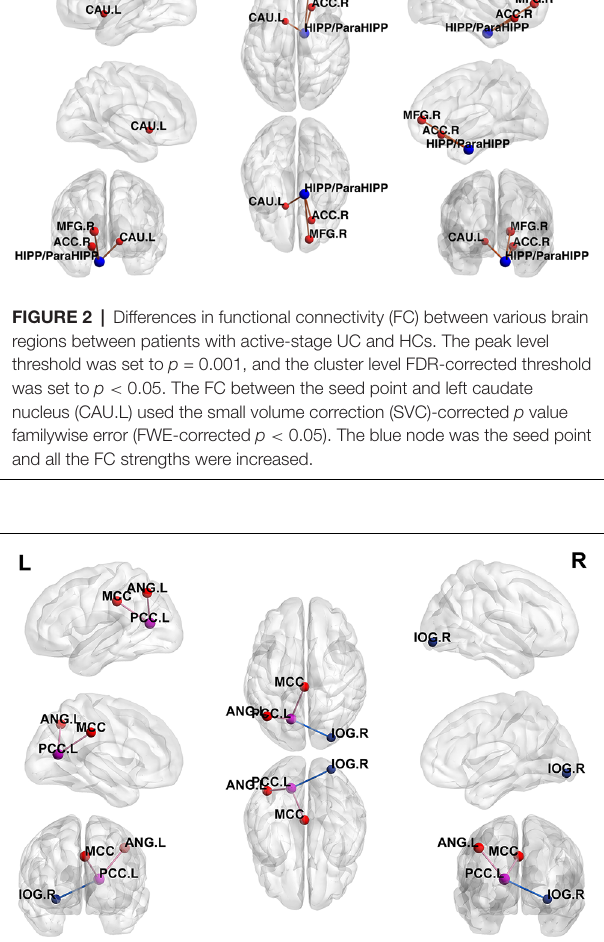
FIGURE 3 | Differences in whole-brain FC between patients with active-stage UC and HCs. The peak level threshold was set to p = 0.001, and the cluster level FDR-corrected threshold was set to p < 0.05. The purple node represents the seed point, the purple lines indicate an increased FC strength and the blue line indicates a decreased FC strength.